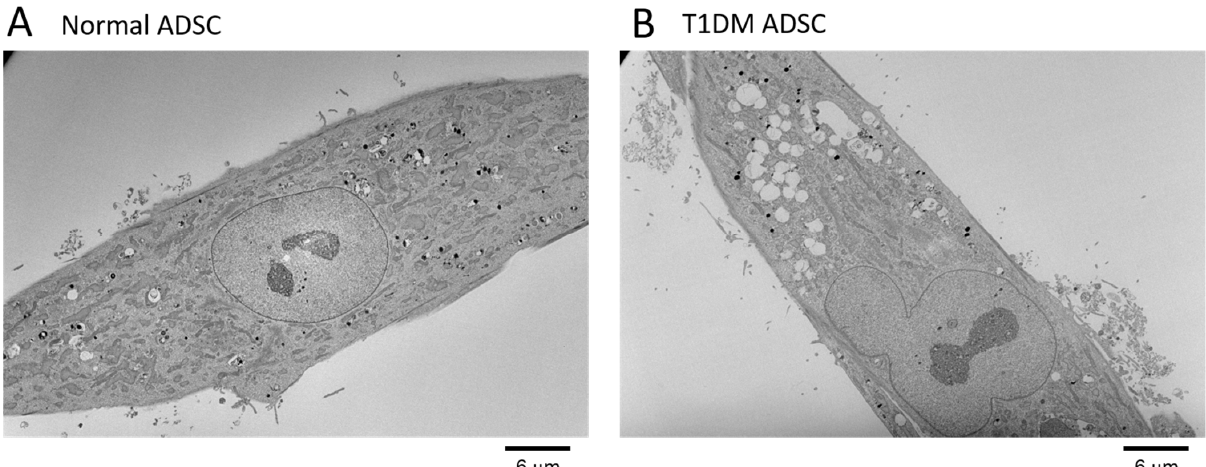
Figure 1. Electron microscopic images of the whole cells in adipose-derived mesenchymal stem cells (ADSCs). Whole-cell transmission electron microscope (TEM) images of ADSCs are shown. ( A ) A whole-cell image of normal ADSCs. ( B ) A whole-cell image of adipose-derived stem cells of patients with type 1 diabetes mellitus (T1DM ADSCs). The scale bar measures 6 µm.